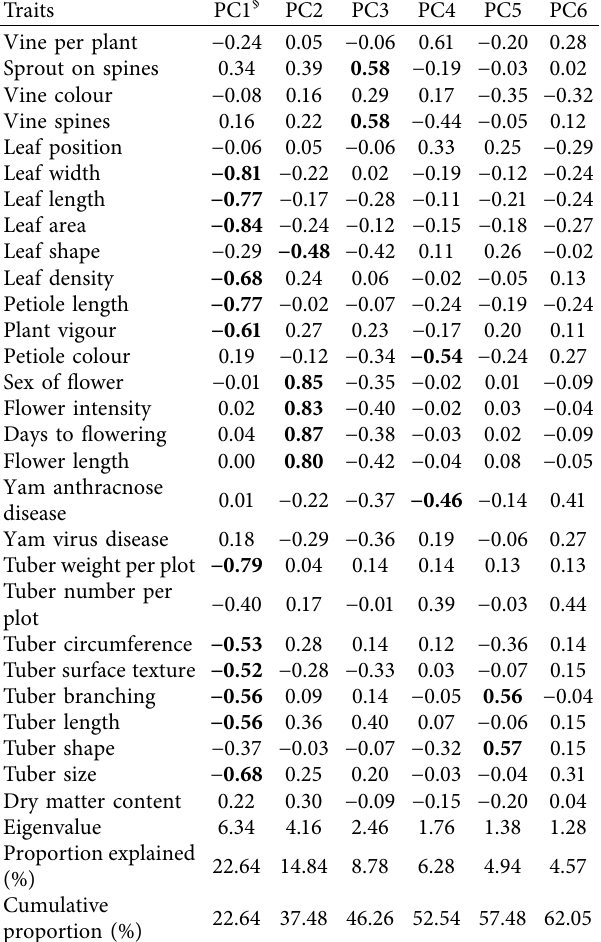
Table 4: Te proportion of the morphological variation and traits contribution explained by the frst six principal components.